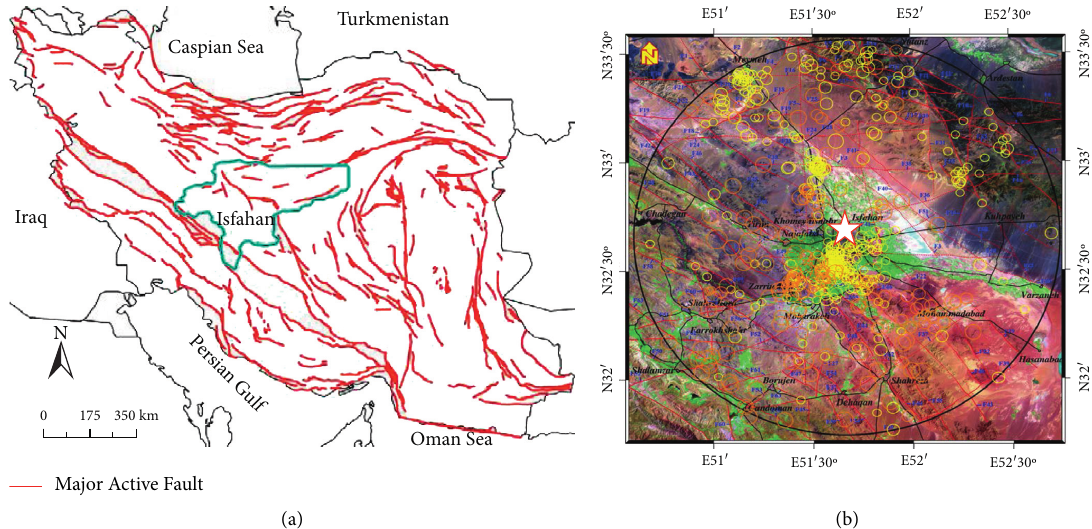
Figure 11: (a) Major active faults and location of Isfahan in the map of Iran; (b) satellite image for fault density in 100km radius of Isfahan and detected earthquakes in